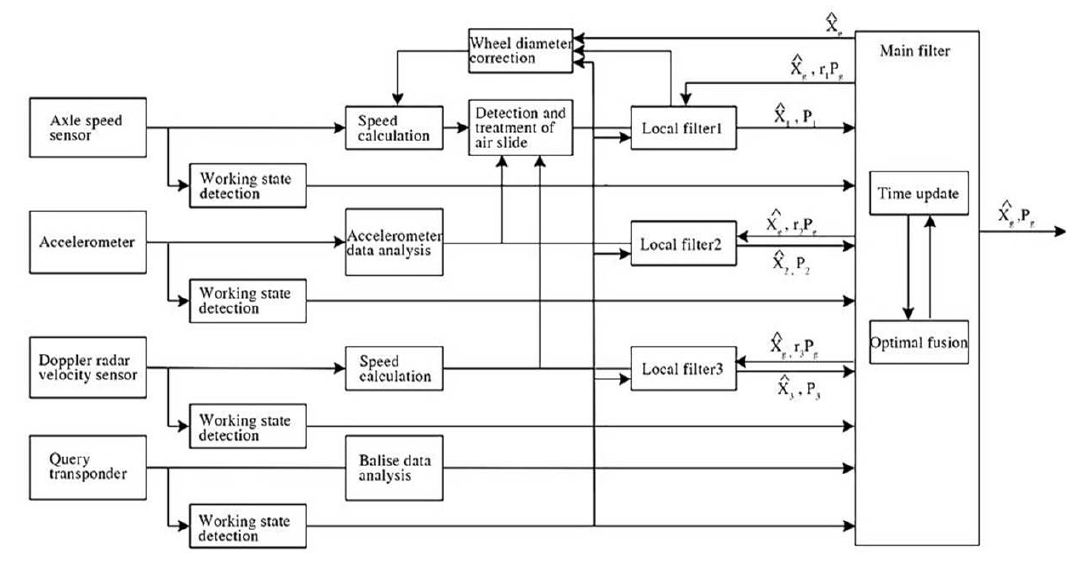
Figure 7: Principle of filtering